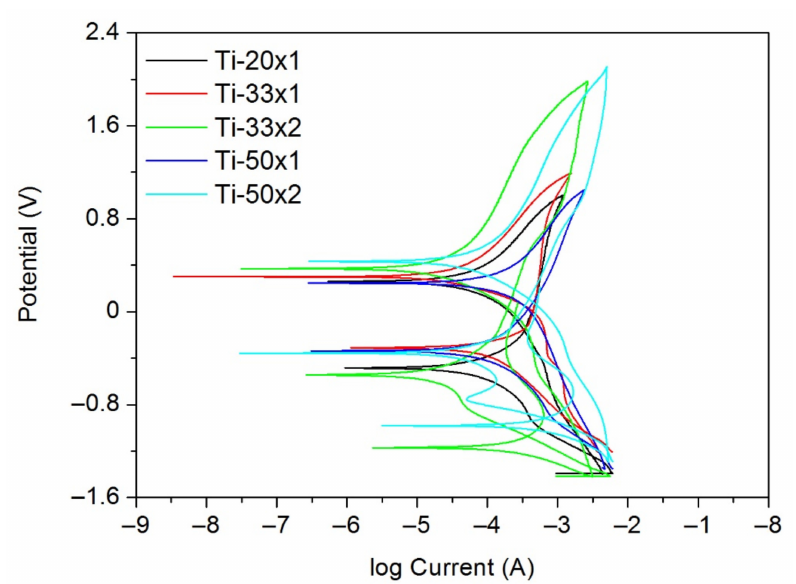
Figure 13. Cyclic polarization tests of each specimen after one hour of immersion in 3.5% NaCl